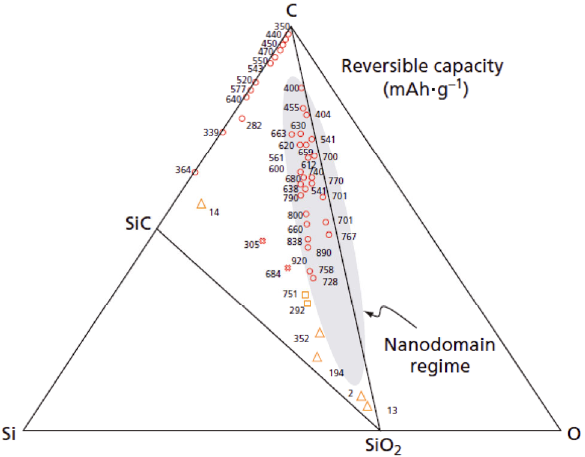
Fig. 18 SiOC compositional triangle. The numbers indicate the reversible capacity of the SiOC anode material depending on the composition. The highest capacity values are found for compositions containing mixed Si bonds (grey area) where silicon is tetrahedrally bonded to oxygen and carbon. Reproduced with permission from Ref. [399], © ICE Publishing 2012; Ref.